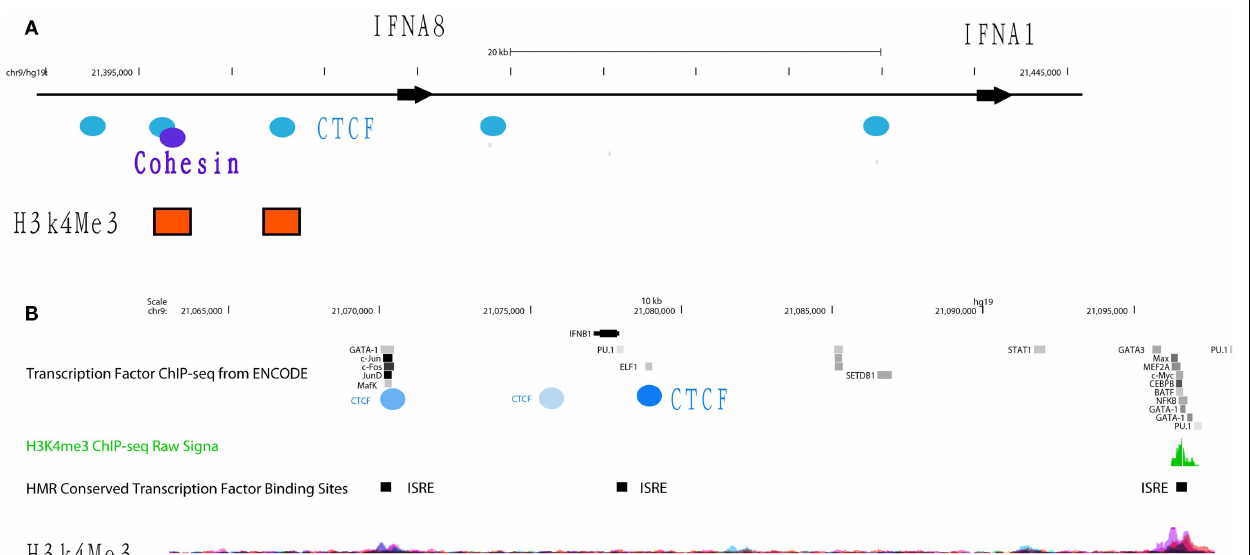
FIGURE 4 | Differential occupancy for insulators CTCF and cohesin on the IFNA8 and IFNB genes . (A) The genomic regions of IFNA8 and IFNA1 are shown proportionally according to Human ( Homo sapiens ) Genome hg19. CTCF (blue circles) and cohesin (purple circles) occupancy positions are marked according to transcription factor ChIP-seq datasets from ENCODE. Orange squares indicate positions enriched with H3K4Me3 signals. (B) The